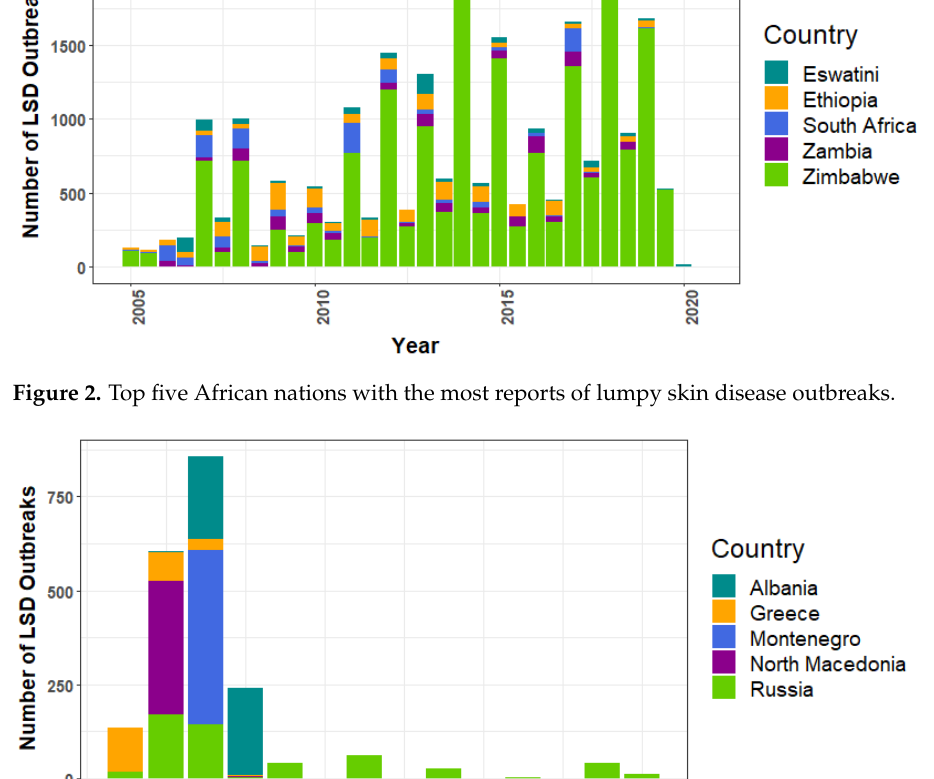
2019. During the period from 2021 to January 2022, Thailand had the highest number of LSD reports.